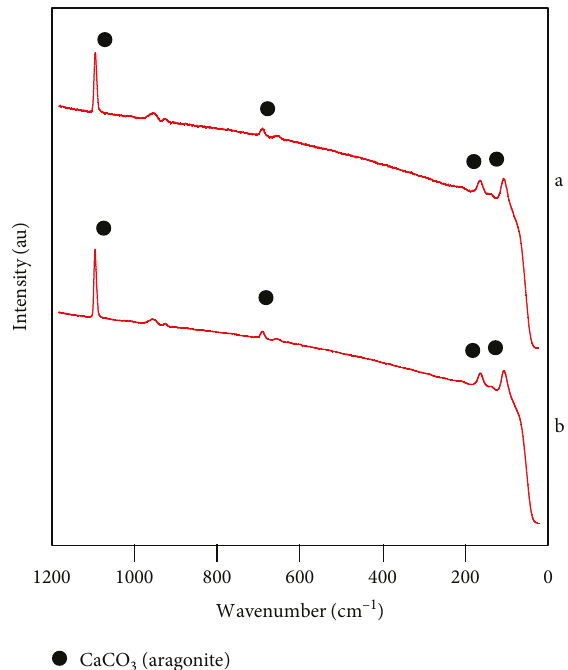
Figure 5: Laser Raman spectrum on (a) and near the CaCO microparticle (b).